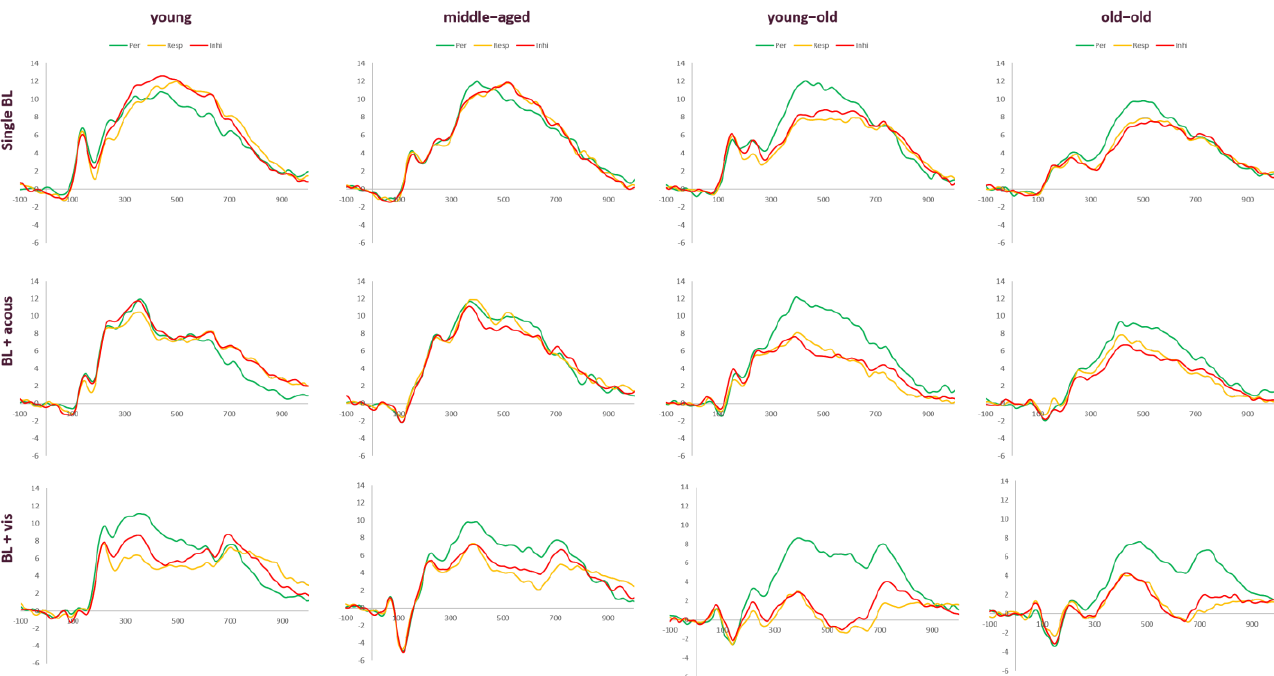
Figure 6. Grand-average target-locked P3b components of the four age groups in the perception-only task (Per), response task (Resp) and inhibition task (Inhi) shown at Pz, presented separately for single brake light, brake light +acoustic stimulus, and brake light + visual stimulus.